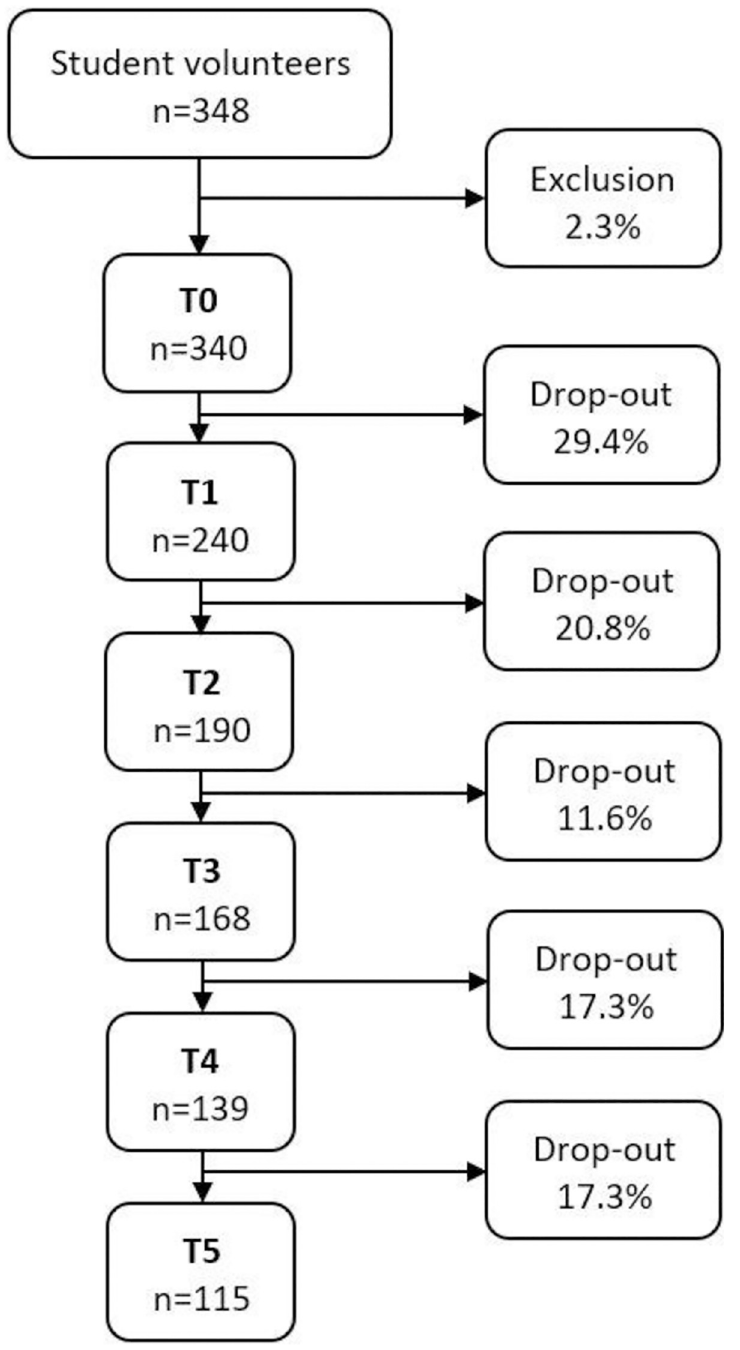
Fig 1. Flow chart with drop-out rates across the